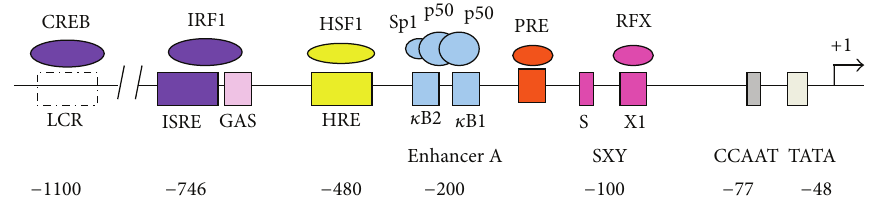
Figure 1: HLA-G unique promoter region. Enhancer A element ( Κ B1, Κ B2, Sp1): NF- Κ B; interferon-stimulated regulatory element (ISRE); interferon regulatory factor (IRF); interferon-gamma activated site (GAS); SXY region; progesterone response element (PRE); hypoxia response element